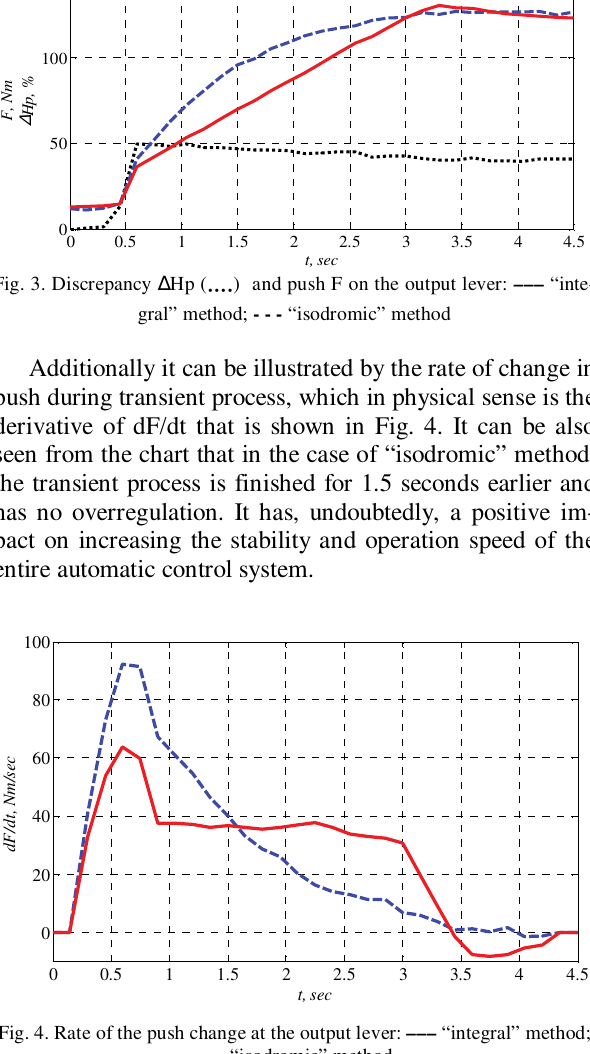
Fig. 4. Rate of the push change at the output lever: ––– “integral” method; - - - “isodromic”